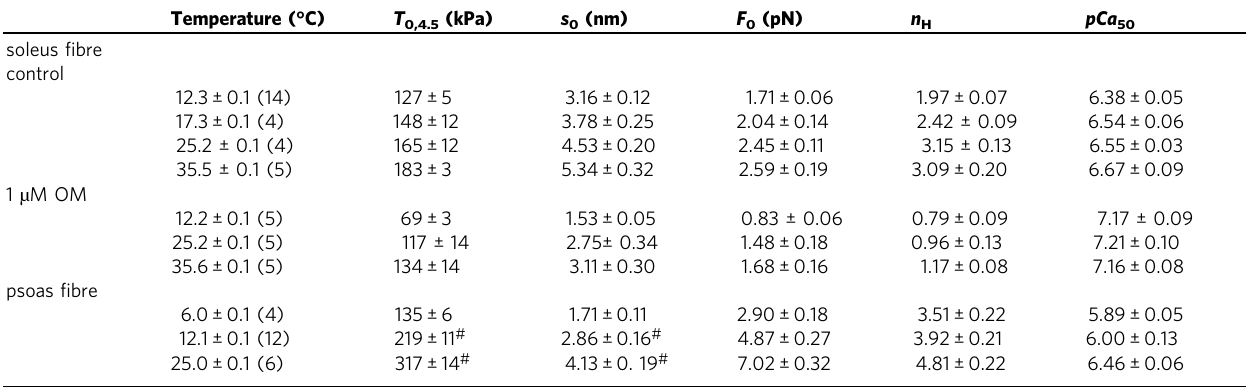
Table 1 Effect of temperature on the relevant mechanical parameters listed on the fi rst